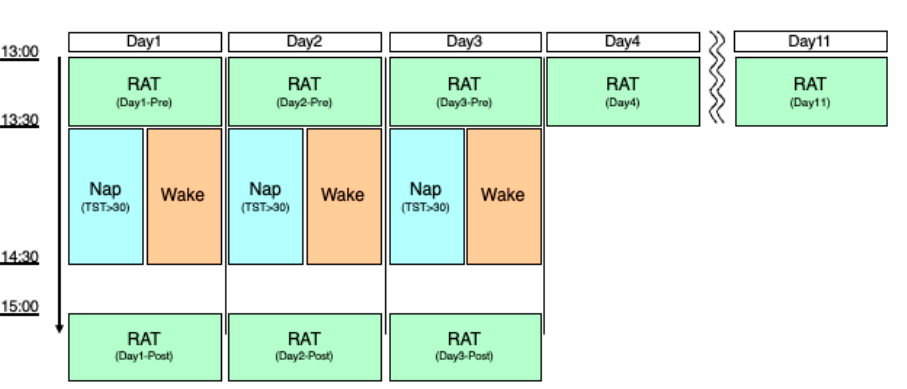
Figure 4. Schematic diagram of the experimental protocol. Abbreviations: RAT, rotation adaptation task; TST, total sleep time.